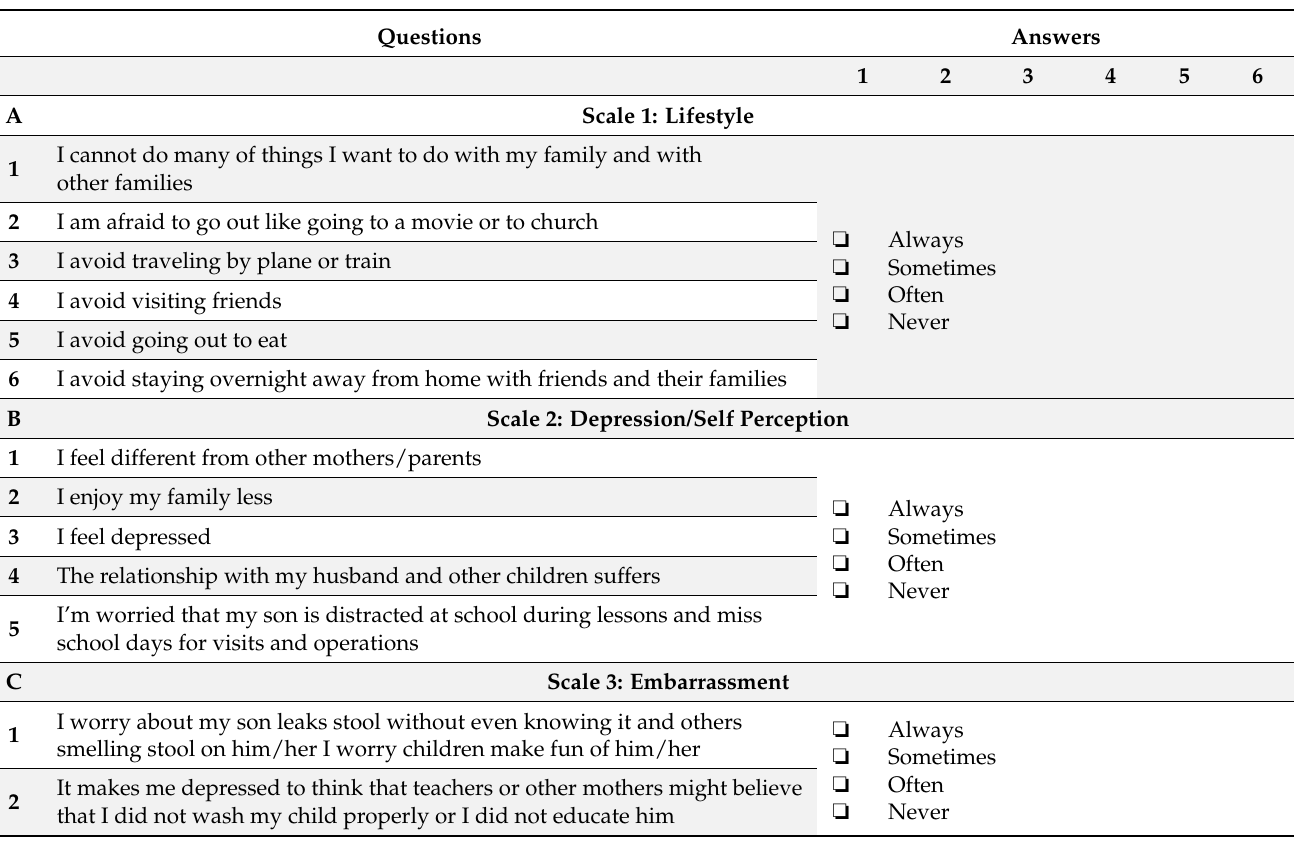
Table 2. Parents’ QoL